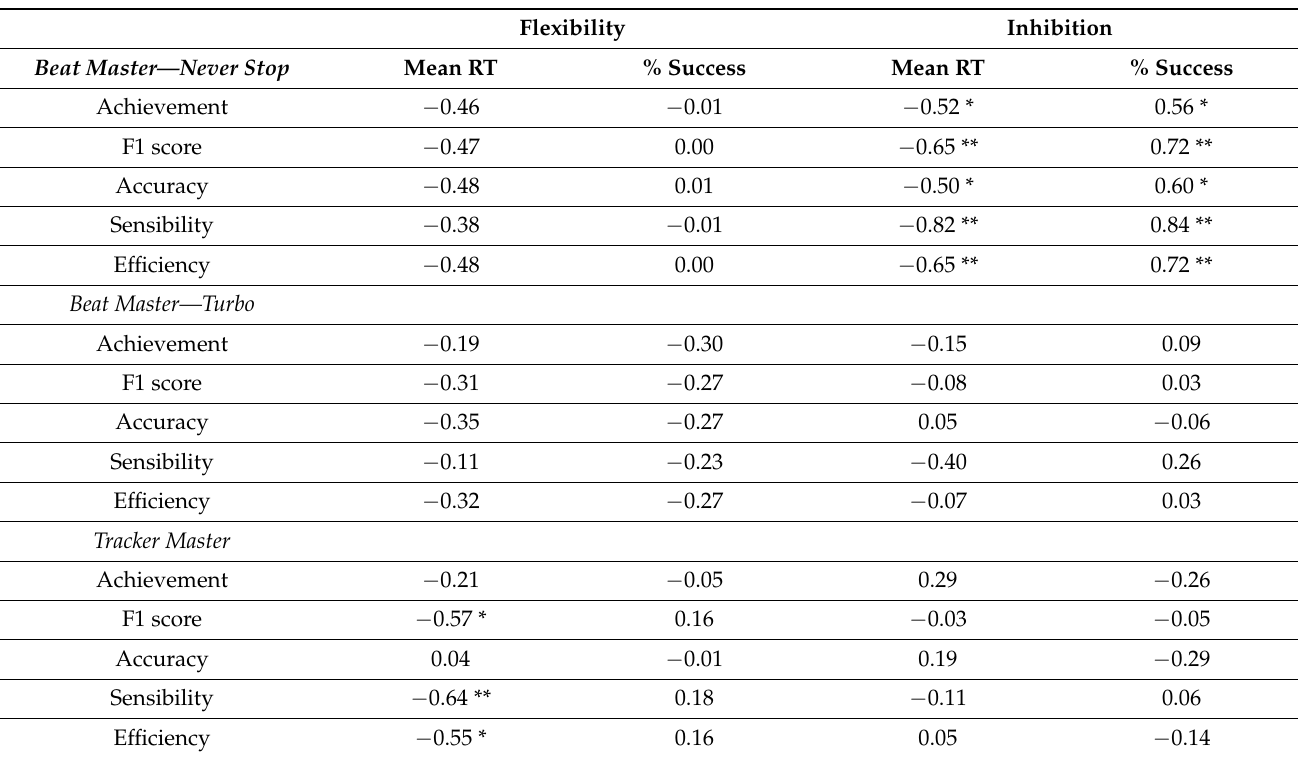
Table 2. Association between the scores provided by the virtual reality device during the games and executive performance during the computerized modified Stroop